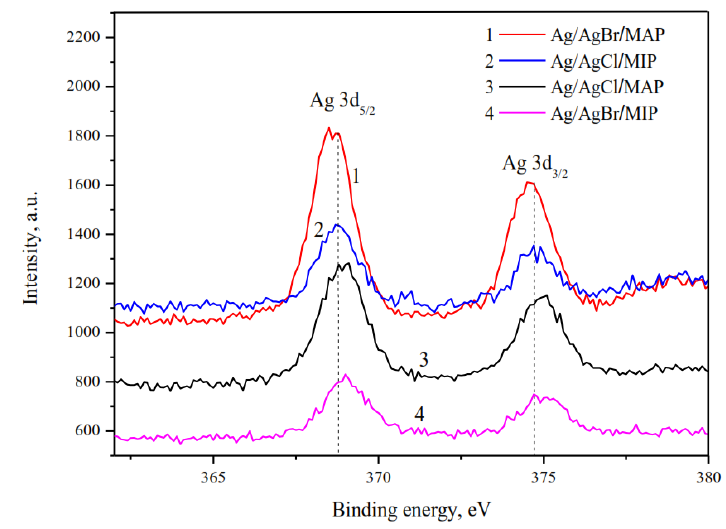
Figure 2. High-resolution XPS spectra of Ag 3d.